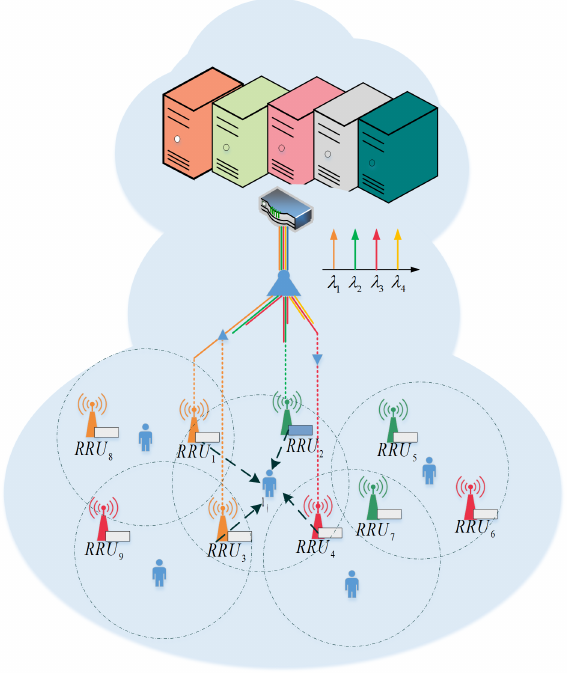
Figure 1. System